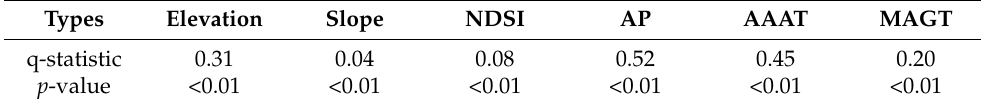
Table 3. The q-statistics of the contribution of each factor to NDVI gs along National Highway G214 from the Changshitoushan Mountain Pass to the Qingshui’he Riverside at the northern and southern flanks of the Bayan Har Mountains, southern Qinghai, China, from 2010 to 2019.